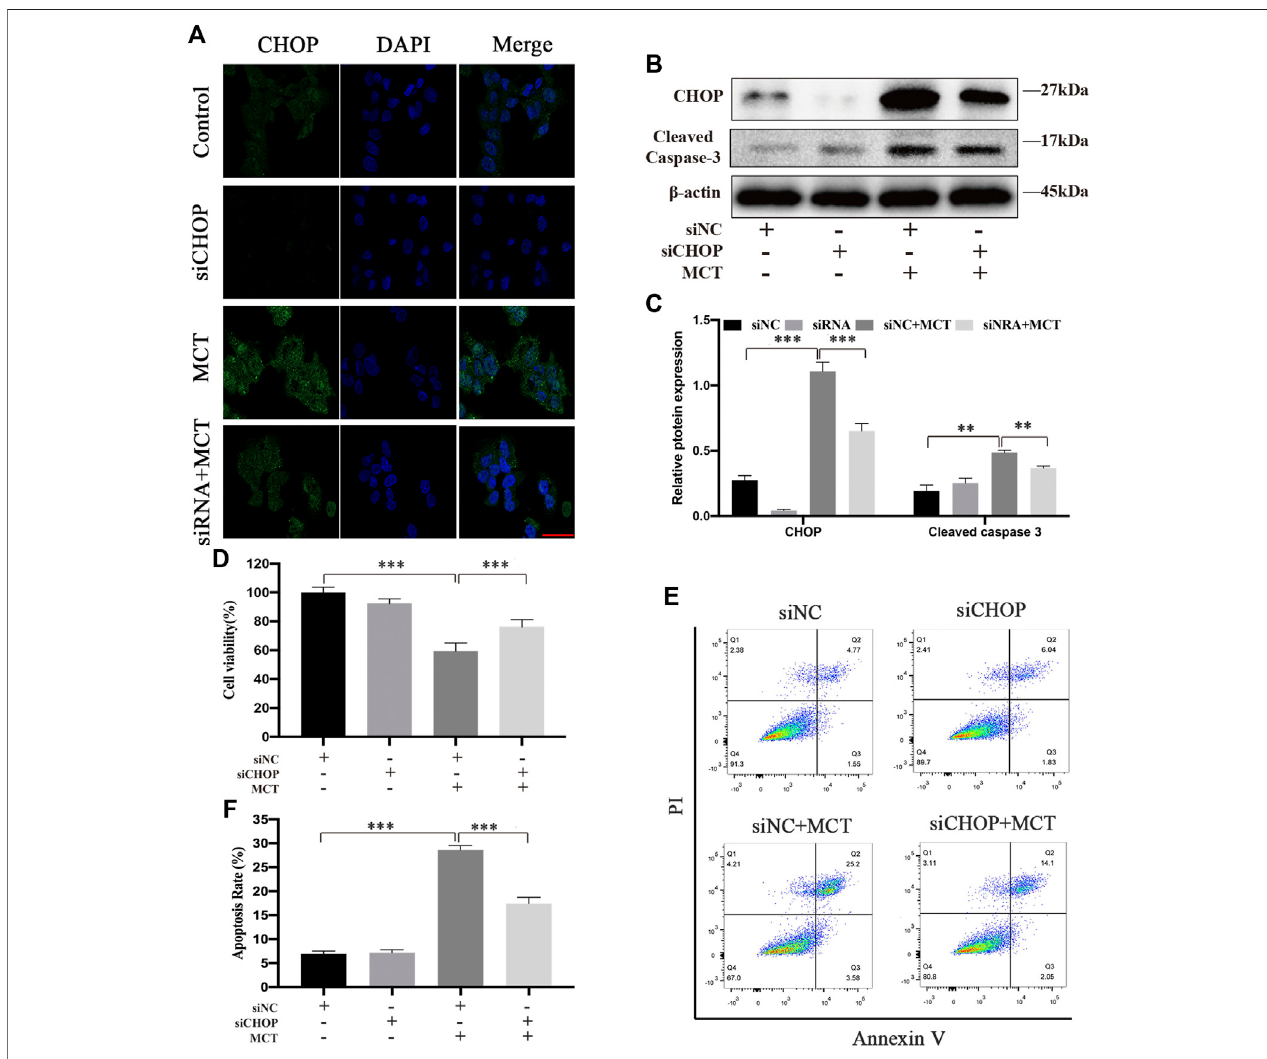
FIGURE5| CHOPsiRNApartiallydecreasesMCT-inducedapoptosisofprimaryrathepatocytes.AfterpretreatmentwithCHOPsiRNA(100 nM)orsiNC(100 nM) for24 h,thehepatocytesweretreatedwithorwithout300 μ MofMCTforanother36 h. (A) Representativeimmuno fl